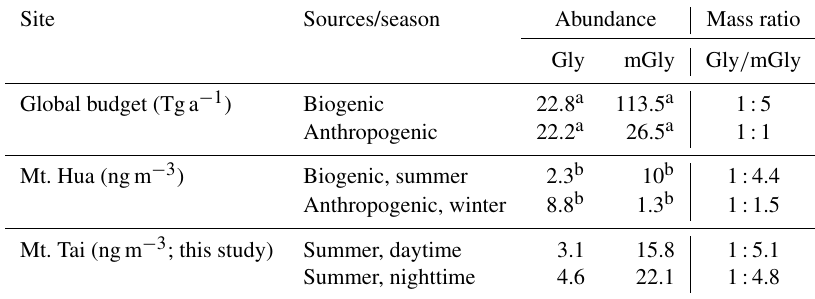
Table 3. Concentrations of α -dicarbonyls in PM 2 . 5 from Mt. Tai and Mt. Hua in China and the global budgets of atmospheric Gly and mGly. Site